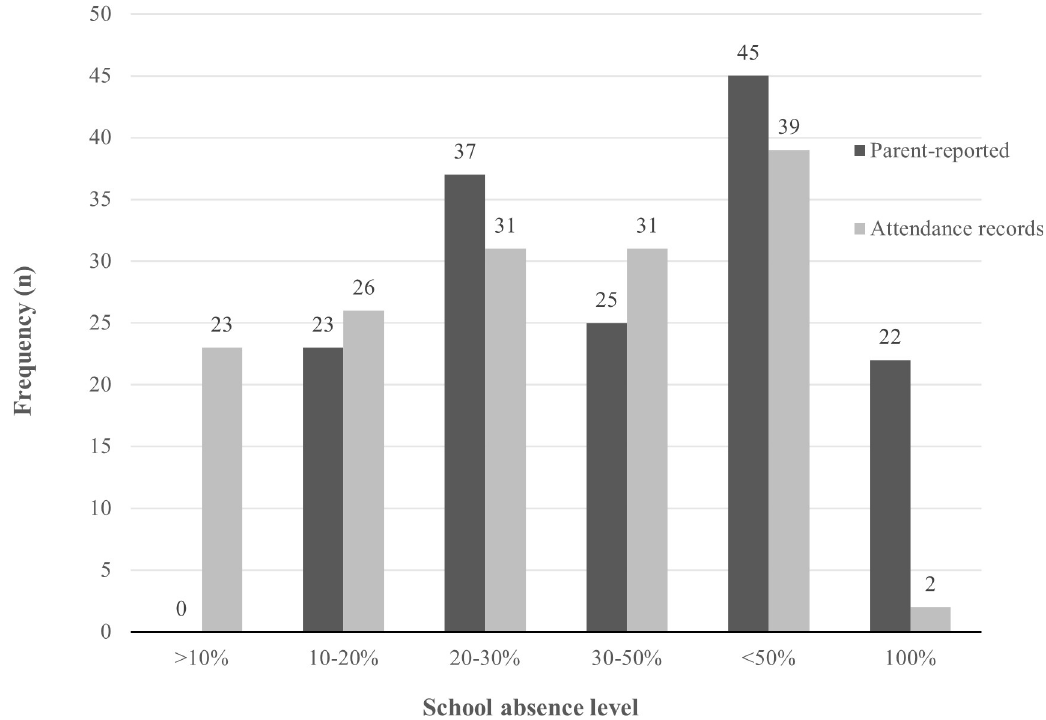
Fig 1. Frequency distribution of youth school absence using parent-reports and attendance records, in the previous three- months of school.